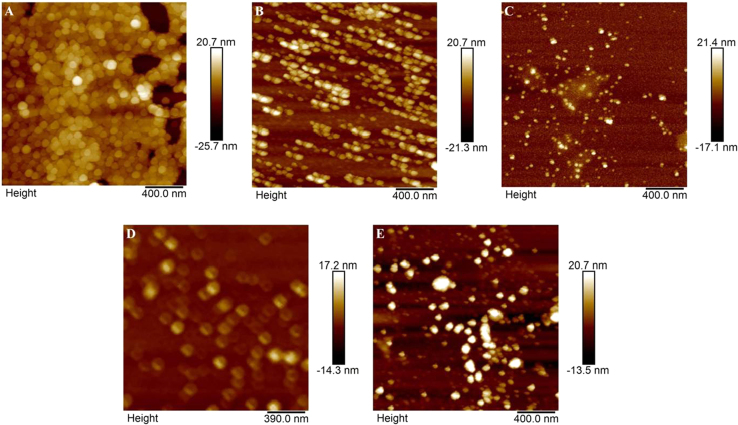
AFM images recorded on CZTSxSe1-x nanocrystals dispersion dropcasted on silicon wafer for x=0–1. (A) x=1 (B) x=0.74, (C) x=0.42, (D) x=0.17 and (E) x=0.